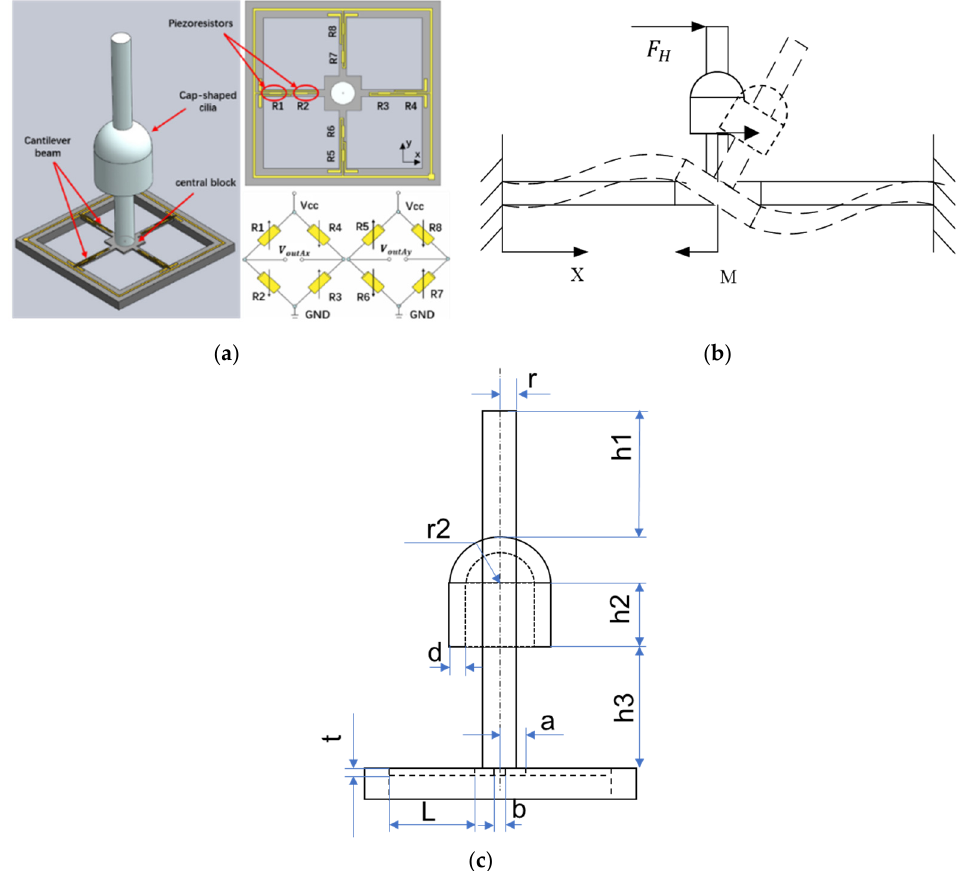
Figure 1. ( a ) Sensitive structure of vector channel. ( b ) Schematic diagram of stress on beam. ( c ) Geometric parameter schematic of vector channel. Table 1. Parameters of sensitive